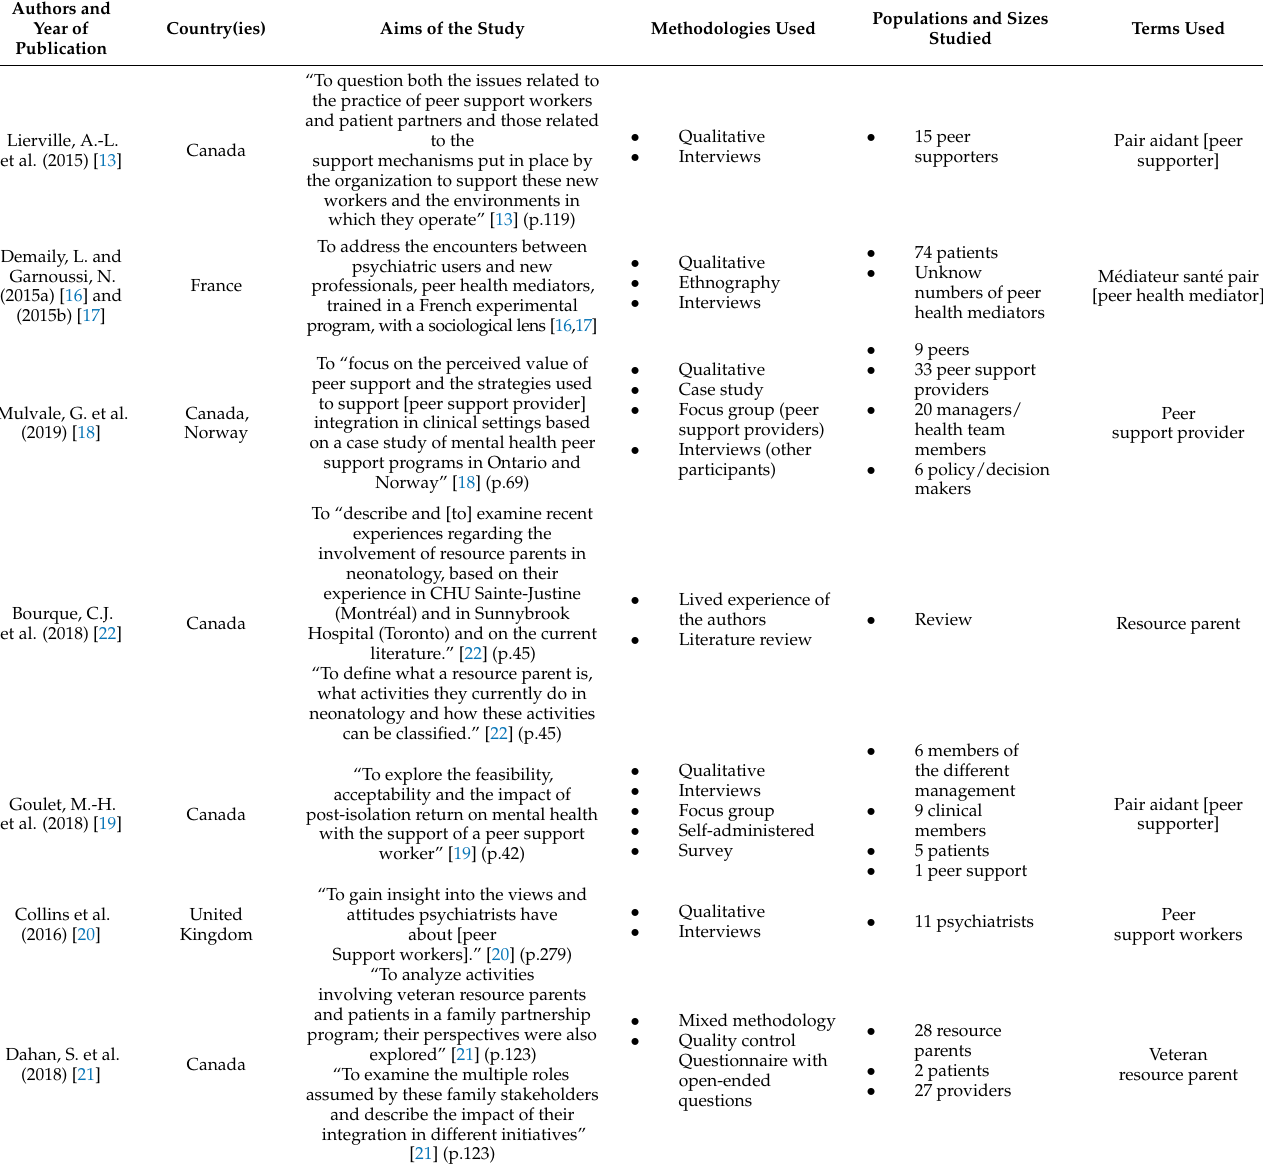
Table 1. Characteristics of the studies on the ethical foundation of the AP